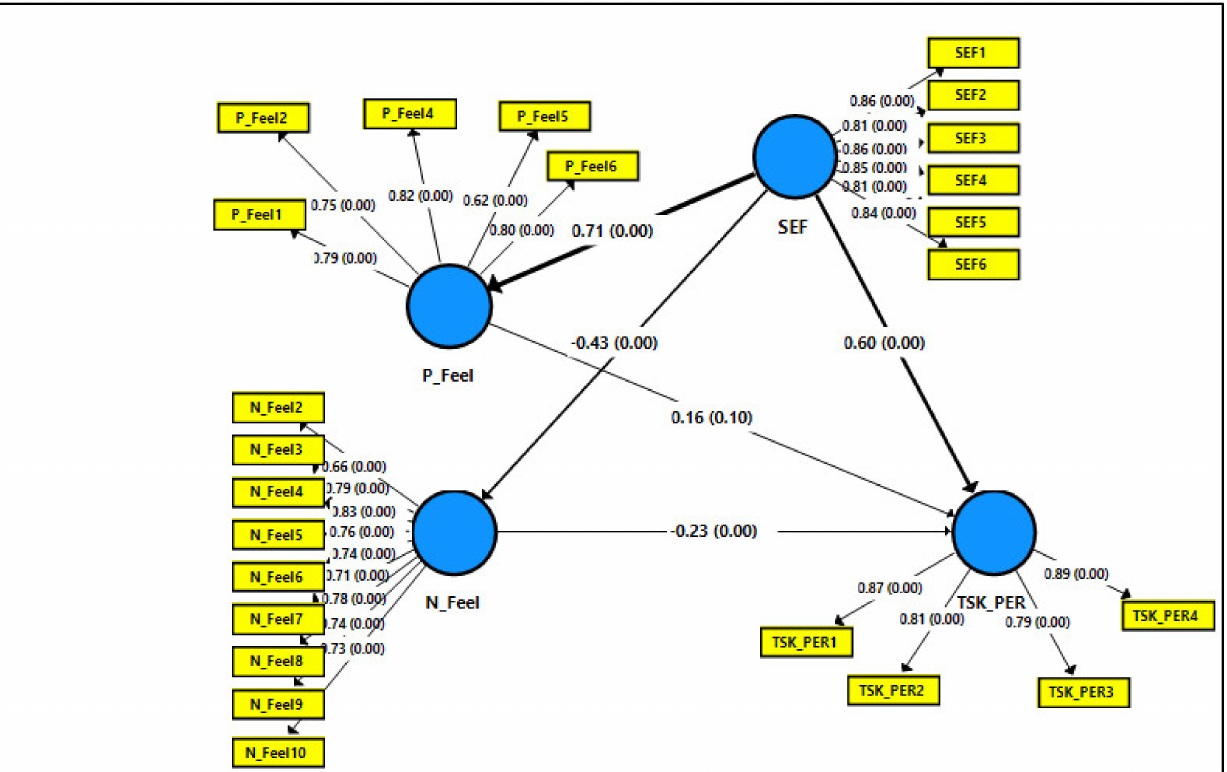
Figure 11. Structural model